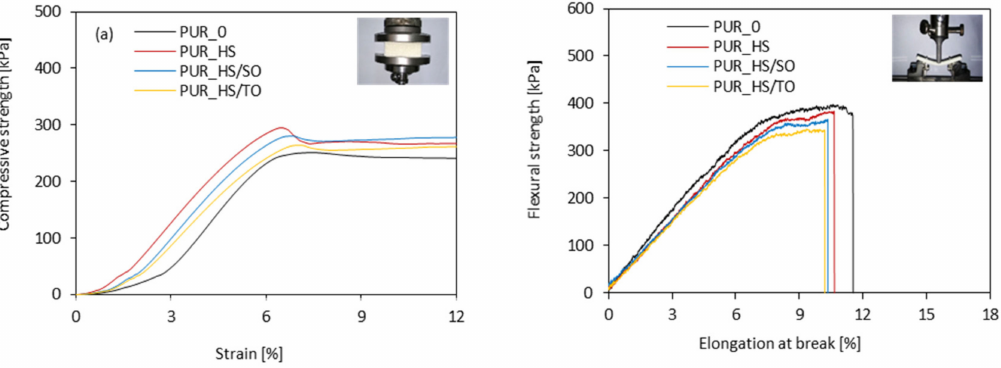
Figure 6. Mechanical behavior of PUR foams’ ( a ) compressive and ( b ) flexural